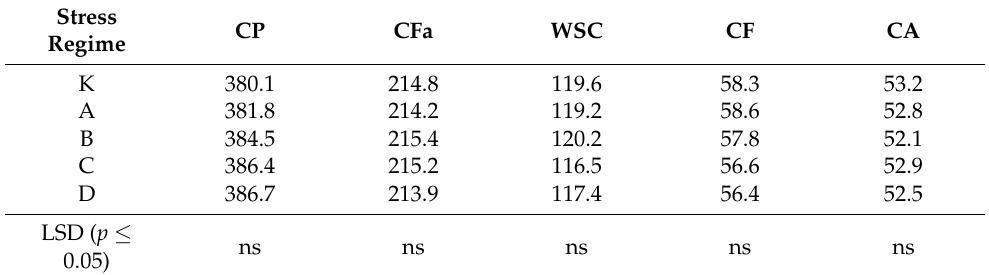
Table 4. Chemical composition of soybean seeds (g kg − 1 ), depending on stress regime (n =